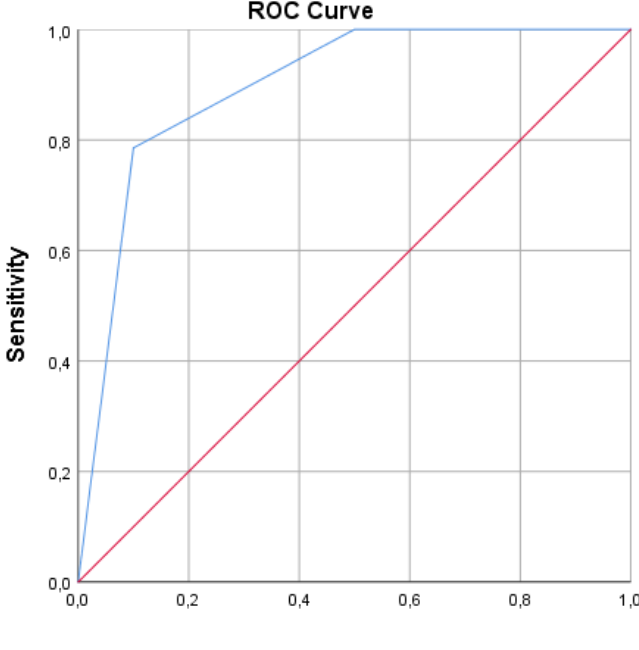
Fig. 1. Area Under the Curve